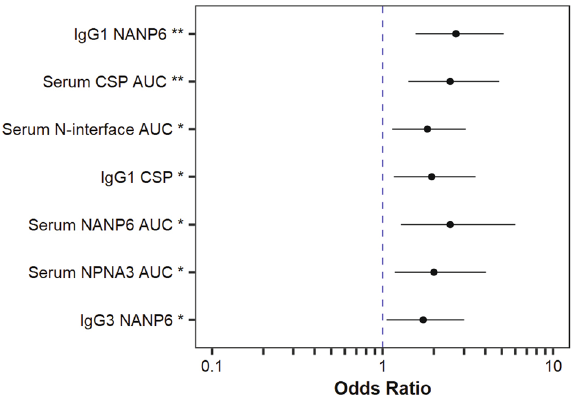
Fig. 2 NANP repeat speci fi cities, antibody subclass and avidity measurements associate with protection status. Odds ratios (circles) and 95% con fi dence intervals (error bars) obtained from logistic regression models fi t individually to each immune measure- ment. Regression models were fi t using both studies combined and were adjusted for regimen arm (Protection ~ Regimen + Measure- ment). Effects were considered signi fi cant and measurements are shown here if raw p -value < 0.05 and FDR-adjusted p -value < 0.2